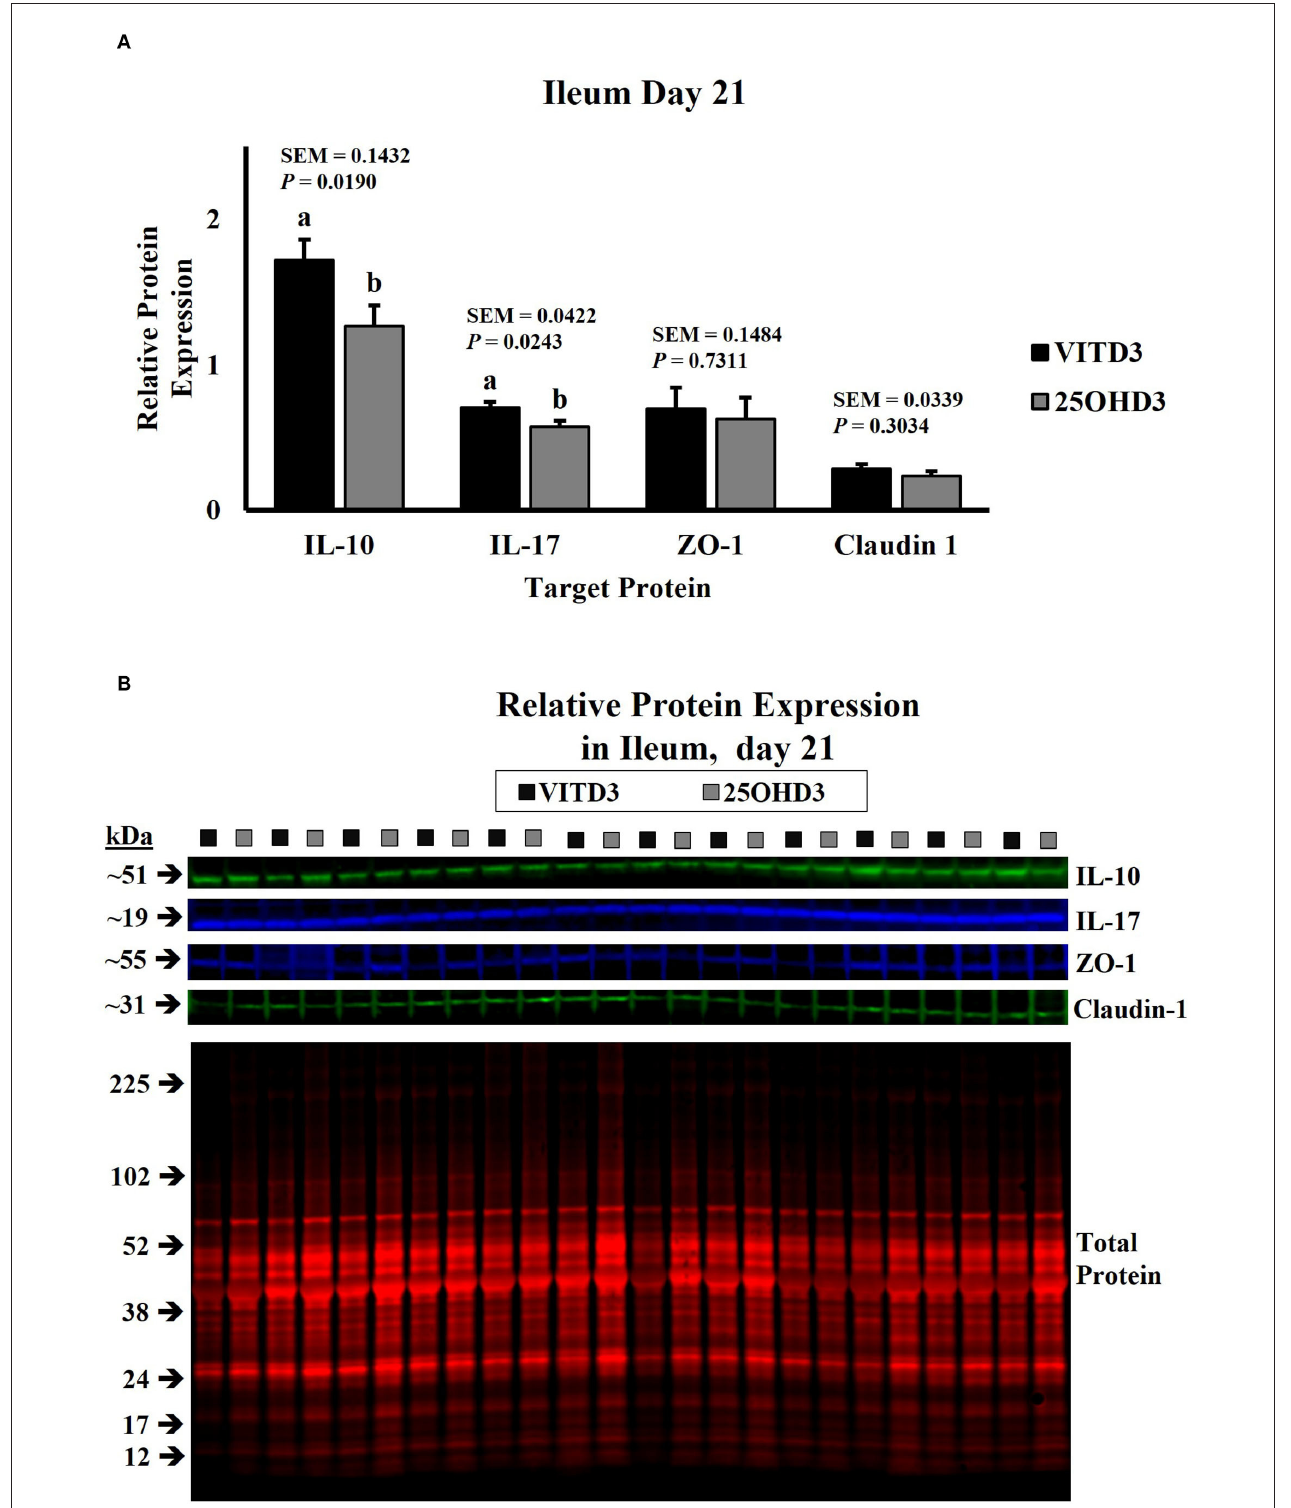
FIGURE 2 | Effect of dietary 25-hydroxycholecalciferol supplementation on 21-day-old broiler chicken ileal protein abundance. In total, twenty-four birds were sampled on each sampling day (n = 12 birds of each treatment). Dietary treatments: VITD 3 = 5,000 IU of vitamin D 3 per kg of broiler chicken feed; 25 OHD 3 = 2,760 IU of 25-hydroxycholecalciferol + 2,240 of vitamin D 3 per kg of broiler chicken feed. Protein expression was measured using quantitative, fluorescent Western Blot relative to total protein. (A) IL-10, IL-17, ZO-1, and Claudin-1 protein abundance. (B) Day 21 representative fluorescent Western Blot. Abundance of IL-10 and IL-17 was grater for VITD3-fed birds. a,b Bars with different superscripts differ at P ≤ 0.05.